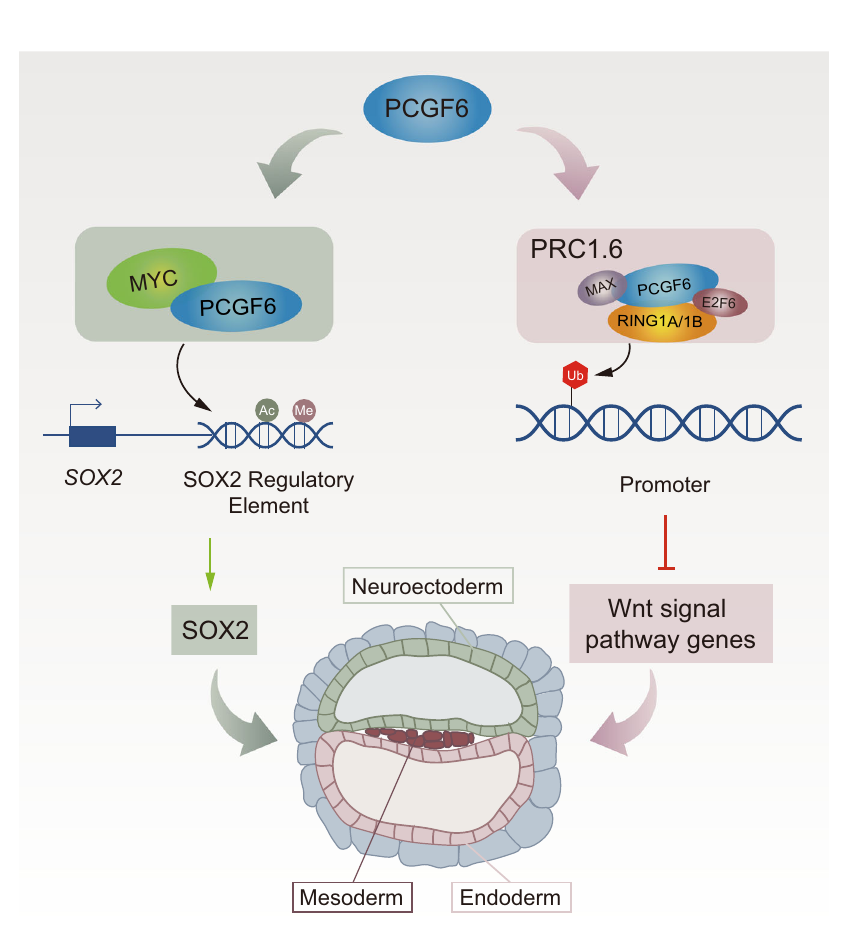
Fig.6|ModelfortheroleofPCGF6inhumanPSCs. PCGF6playsdualfunctionsin regulating human PSCs differentiation. PCGF6 not only recruits MYC to activate SOX2 expression that maintain early neuroectoderm differentiation, but also